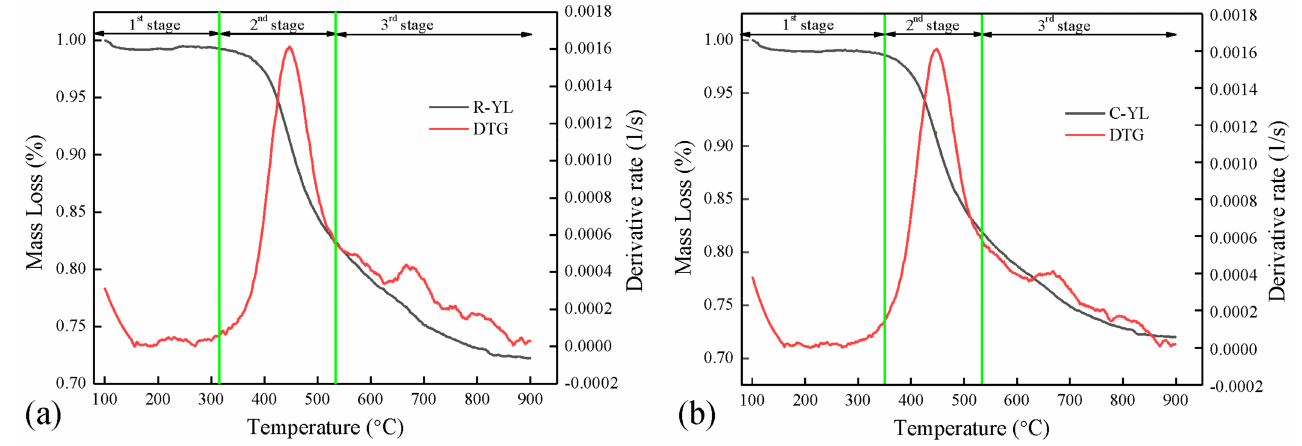
Figure 4. Pyrolysis of R-YL and C-YL in TGA, 10 K/min, 1 bar, ( a ) R-YL, ( b )